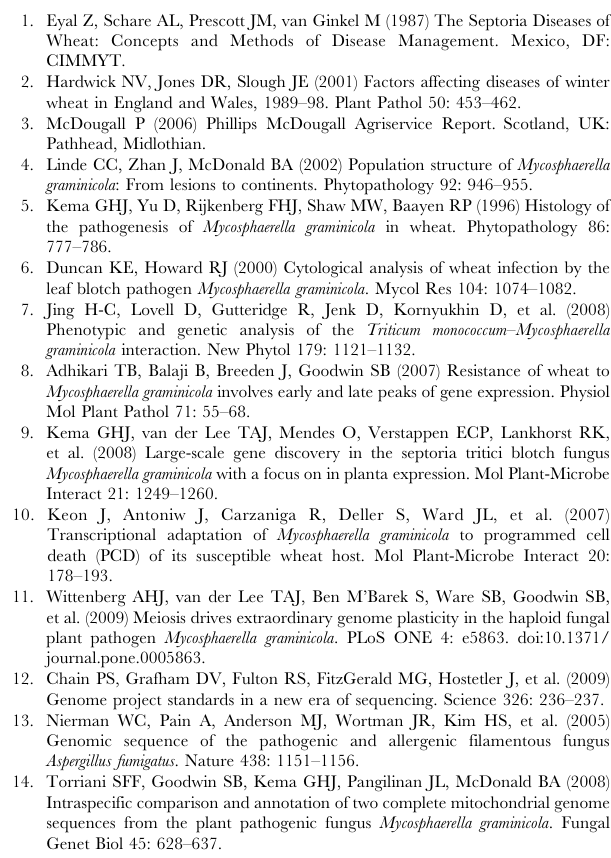
Table S1 List of functional domains or other annotations for 65 genes on dispensable chromosomes 14–21 of the genome of Mycosphaerella graminicola . Table S2 Analysis of small RNA sequences (generated on the Illumina platform) for the presence of computationally predicted pre-microRNA-like (milRNA) sequences in germinated spores of Mycosphaerella graminicola isolate IPO323. Table S3 Best non-self BLAST hits for 654 called genes on dispensable chromosomes of Mycosphaerella graminicola queried with tblastn against a combined database containing the GenBank nt and EST datasets plus M. graminicola version 2.0 and M. fijiensis v1.0 from the Joint Genome Institute. Table S4 Numbers of predicted enzymes degrading hemicellu- lose, pectin and cutin across seven ascomycete species with sequenced genomes. Table S5 Total numbers of predicted CAZymes in Mycosphaerella graminicola and selected ascomycetes. Table S6 PFAM domains that are expanded in the genome of Mycosphaerella graminicola relative to those of five other Ascomyce- tes a and two plant-pathogenic Stramenopiles b .